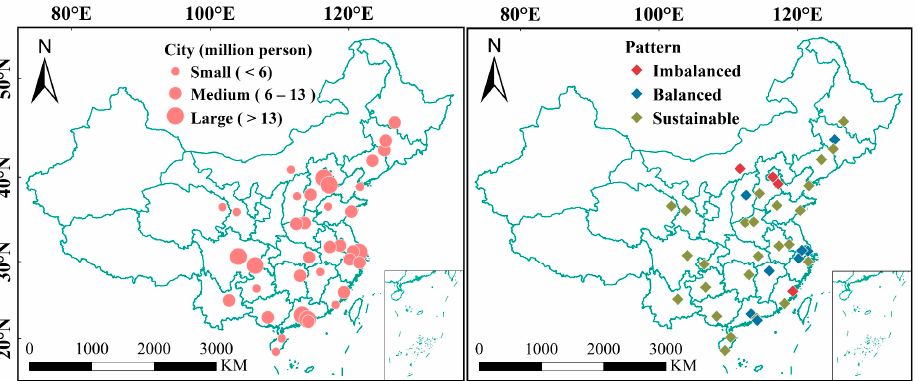
Figure 8. The spatial distribution of cities with different populations sizes ( a ) and the road distribution patterns ( b ).